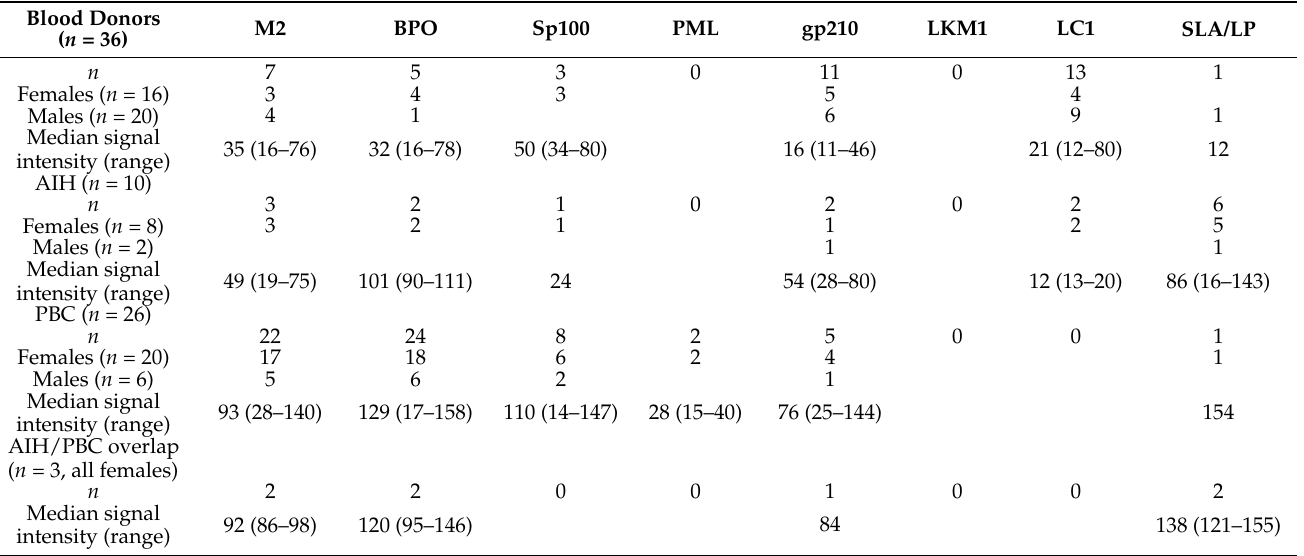
Figure 2. PBC-associated autoantibodies in blood donors ( n = 22). AMA-M2—E2 subunit of pyru- vate dehydrogenase; BPO—recombinant fusion protein of the E2-subunits of the three main M2- antigens branched-chain 2-oxoacid dehydrogenase complex [BCOADC], pyruvate dehydrogenase complex [PDC] and 2-oxoglutarate dehydrogenase complex [OGDC]; Sp100—speckled protein 100; gp210—glycoprotein 210. Table 2. Number of autoantibody-positive individuals, and the mean signal intensity of each speci- ficity in the blood donor and disease